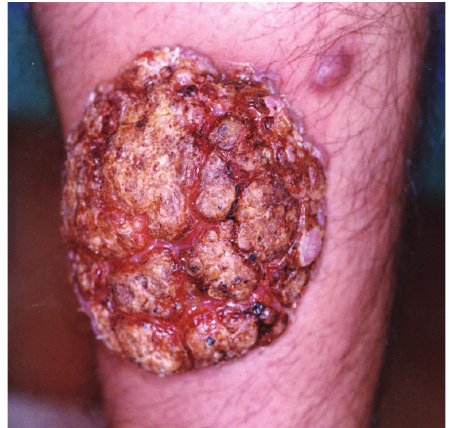
Figure 2: Tumoral lesion on the right shin.